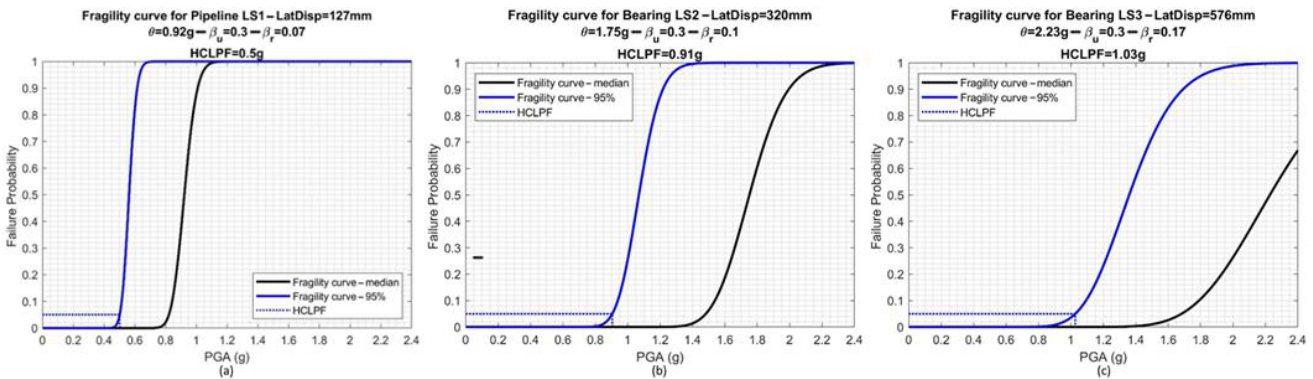
Figure 13. Fragility curve for ( a ) pipeline LS1, ( b ) bearing LS2—LatDisp = 320 mm, and ( c ) bearing LS3—LatDisp = 576 mm.